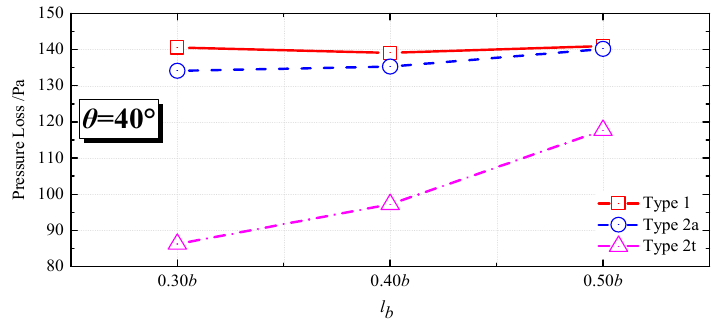
Figure 12. The pressure losses of the RECs with different baffle angles.